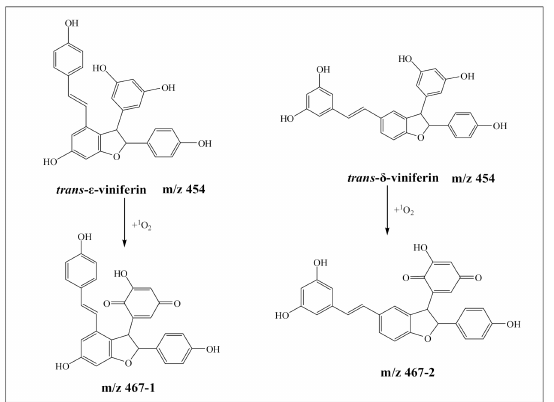
Figure 4. Proposed oxidative products of resveratrol dimers induced by singlet oxygen.